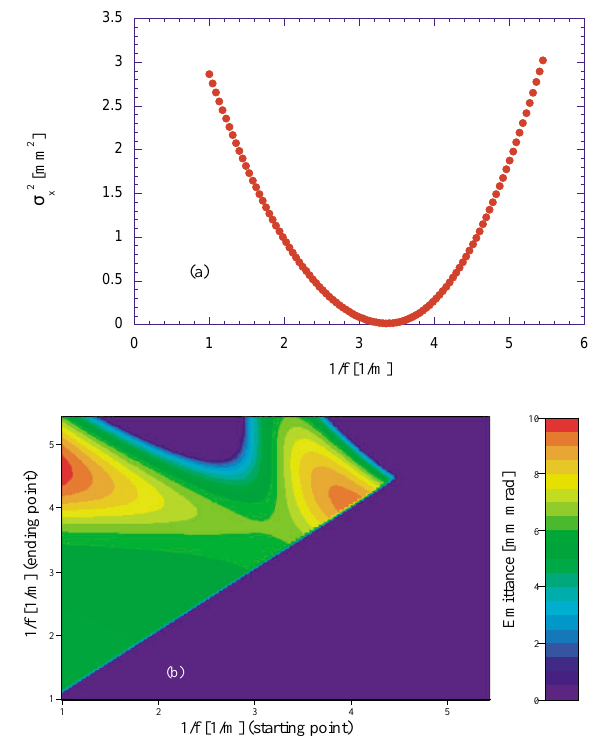
FIG. 12. (Color) (a) Quad scan simulation used to perform the fitting in (b). The emittance used in the simulation is 4 mm mrad. (b) Contour plot of the emittance calculated by fitting the data in (a). The portion of the graph below the diagonal is unused (this half would be the mirror image of the upper half.) Here, red represents an emittance of 10 mm mrad and violet is imaginary (the square of the derived emittance is